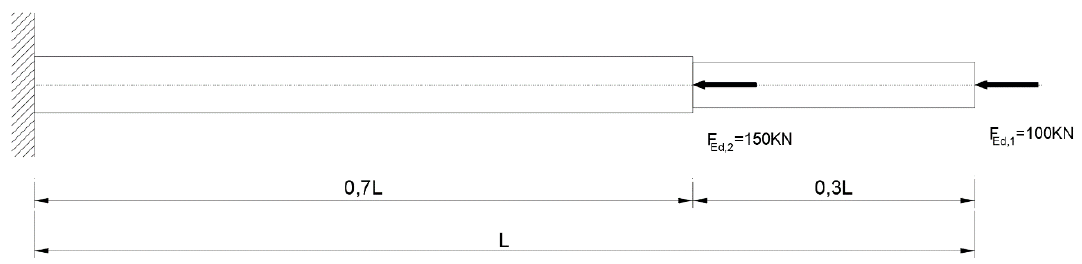
Figure 18. Example 6: description of the member made of aluminum alloy taken from [30] example 6.11.